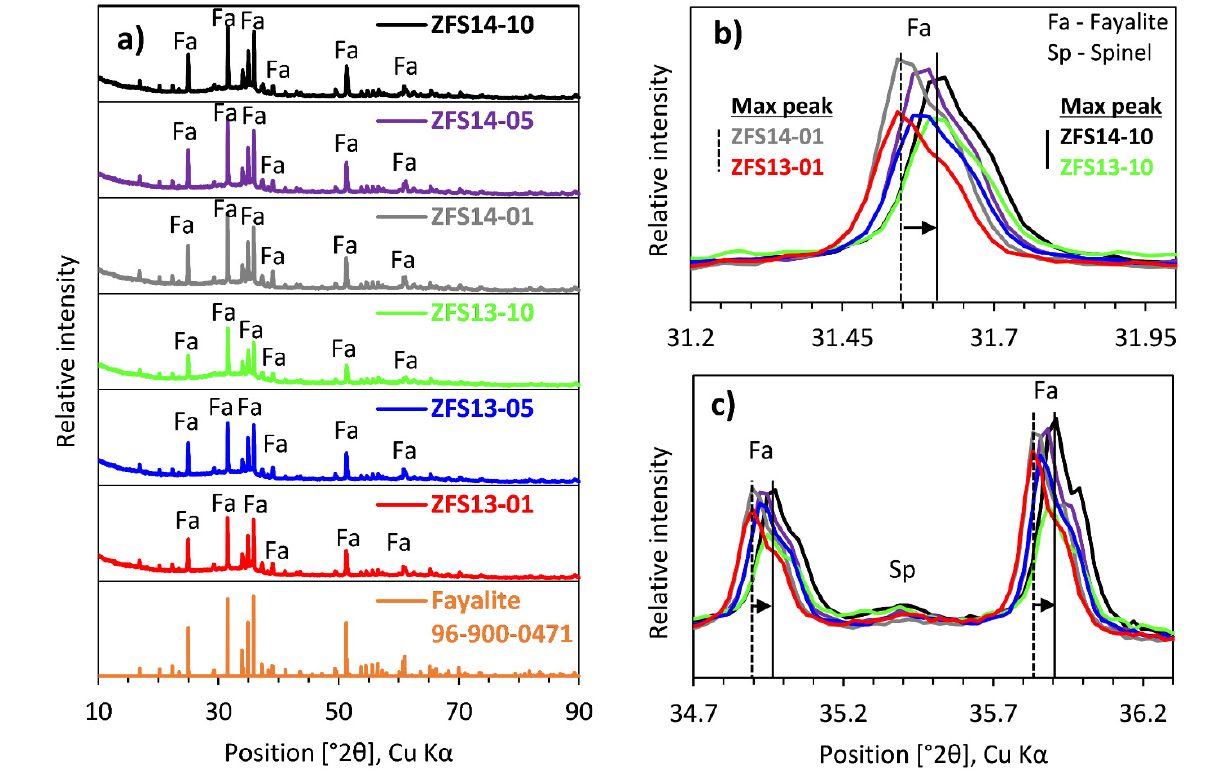
Figure 2. ( a ) X-ray patterns of ZFS samples containing 1, 5, and 10 wt.% ZnO for granulation temperatures of 1300 and 1400 °C; ( b ) main peak; ( c ) second and third peaks of Fa and main peak of Sp with peak shifts (black arrows). Fa, fayalite; Sp, spinel.